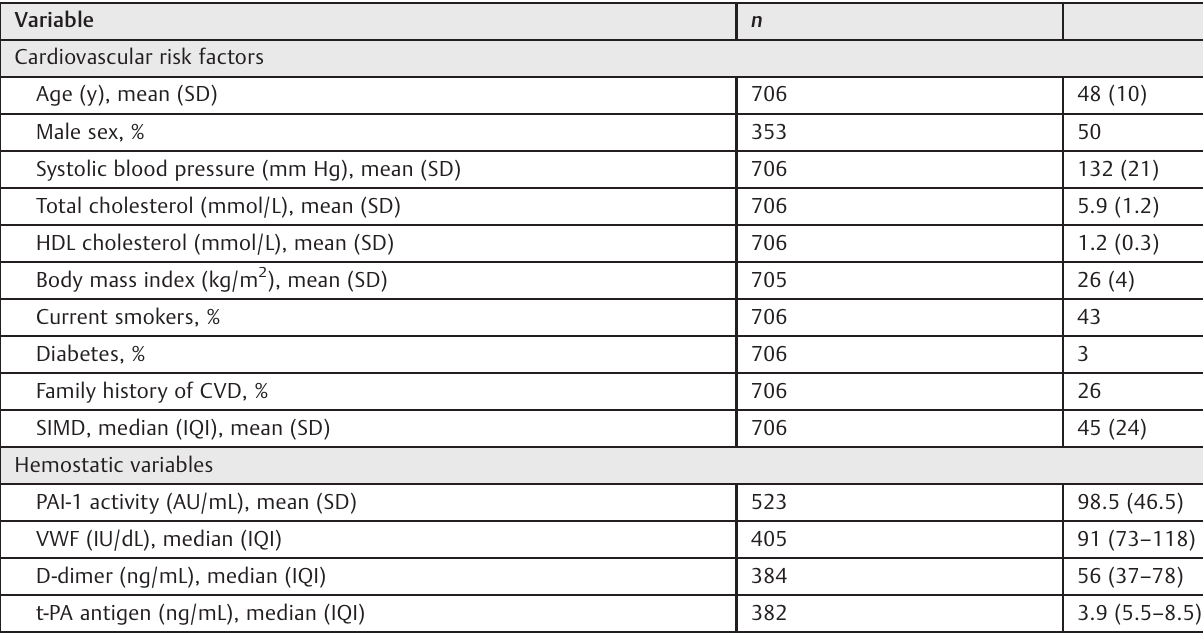
Table 1 Baseline summary statistics: 1989 MONICA survey Variable n Cardiovascular risk factors